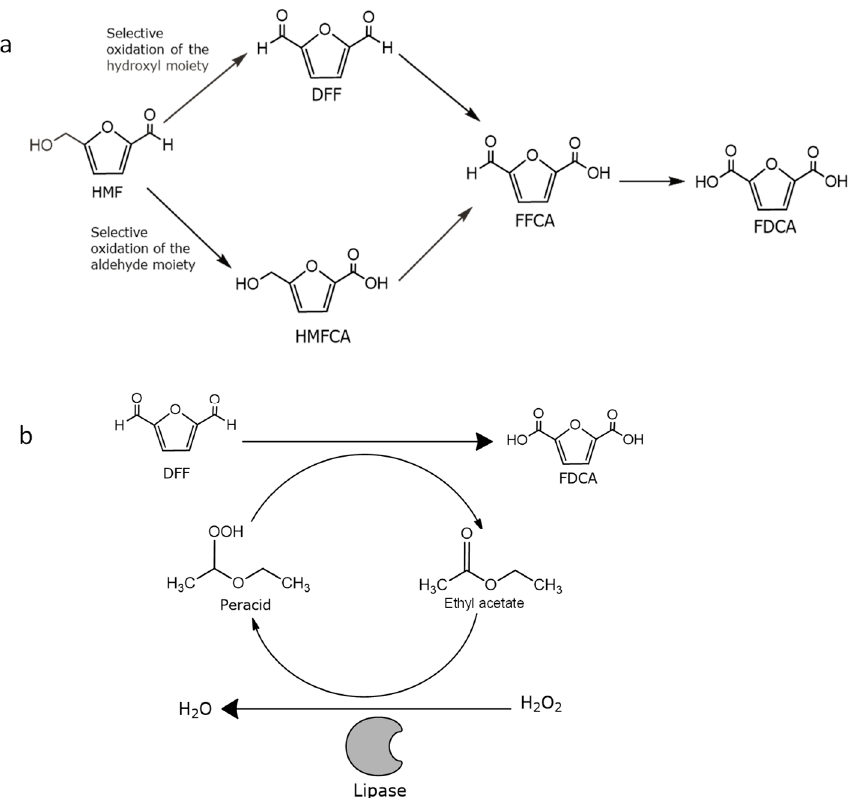
Figure 1. The pathway to produce FDCA. ( a ) From HMF and ( b ) chemoenzymatic oxidation of 2,5-furandicarboxaldehyde (DFF) to 2,5-furandicarboxylic acid (FDCA). HMFCA: 5-hydroxymethyl- 2- furan carboxylic acid, FFCA: 5-formyl-2- furancarboxylic